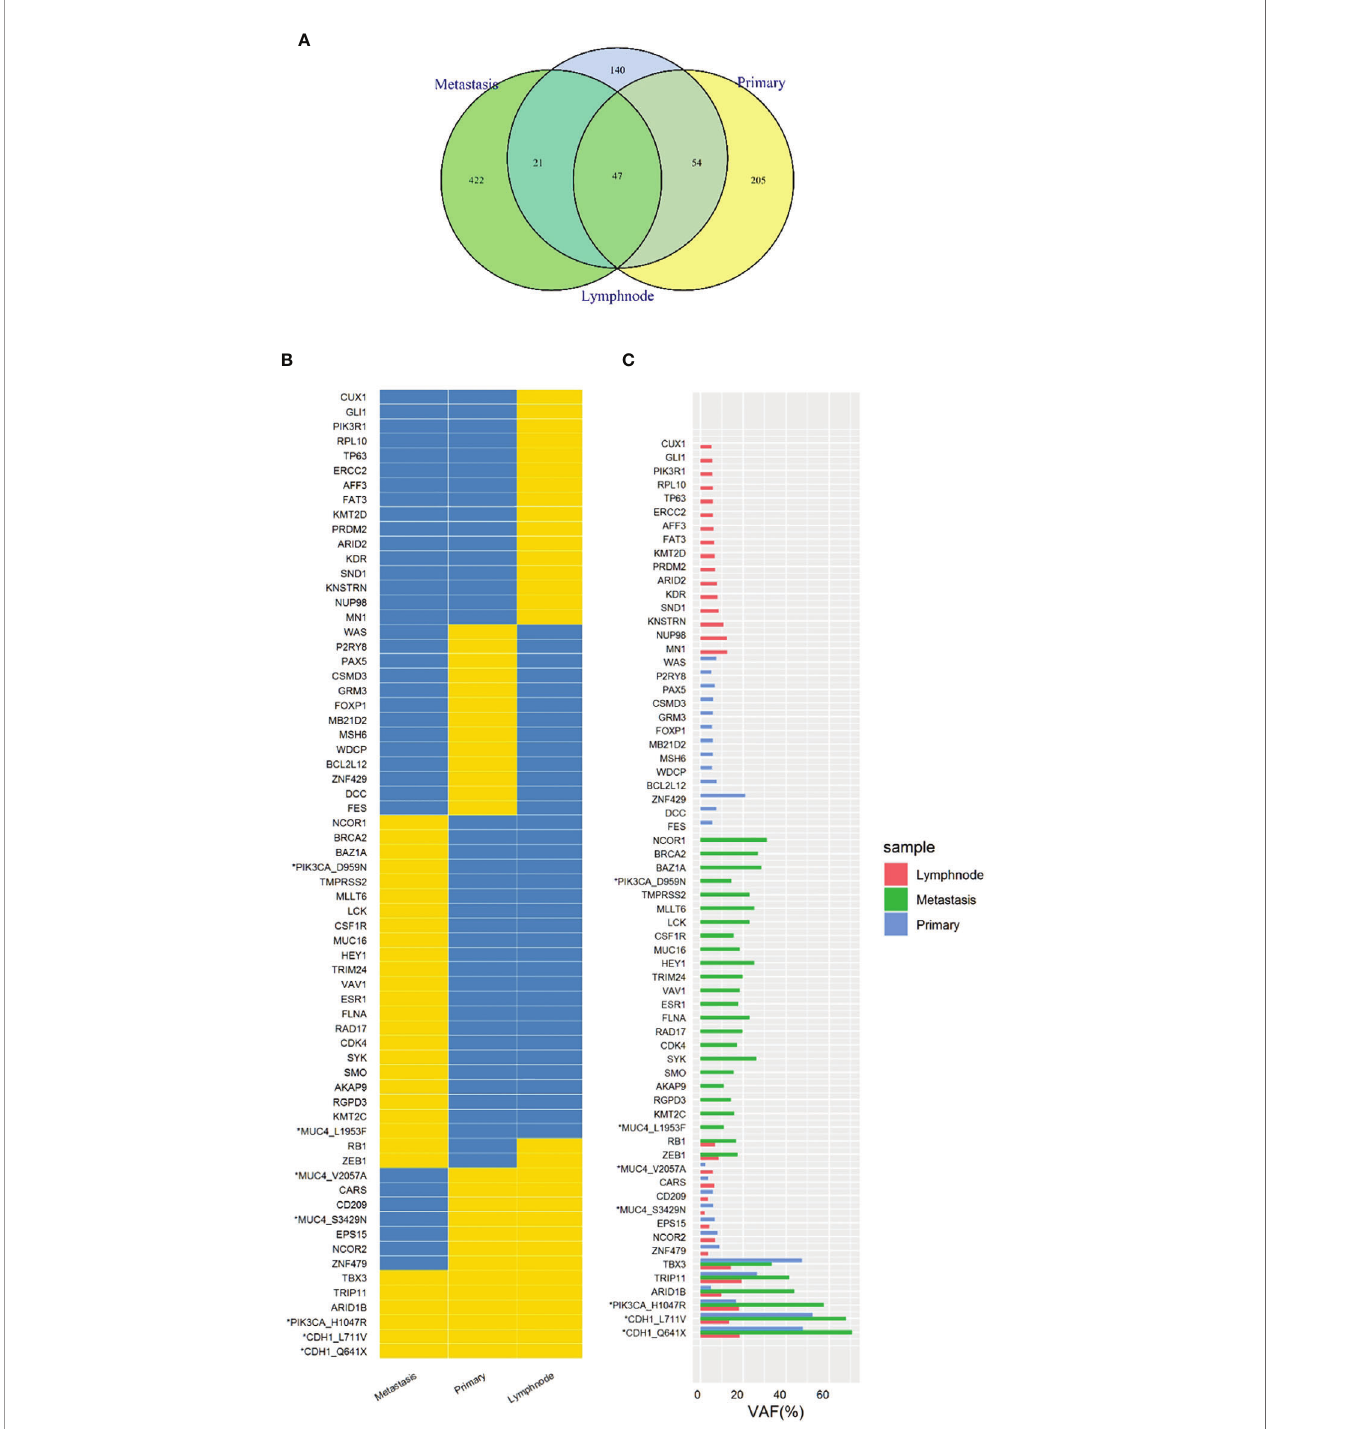
FIGURE 3 | Whole exome sequencing (WES) of tumor samples from primary lesion, regional lymph nodes and peritoneal metastatic lesions. (A) 3-way Venn Diagram showed the mutational overlaps in the three samples. There were 47 common mutations in the three samples, while another 21 common mutations between lymph node and metastatic site, and another 54 common mutations between lymph node and primary site. (B) Somatic mutation heatmap. The mark “ * ” means that there are 2 or more mutations in the same gene, which was labelled with gene or amino acid changes. Yellow means there is variation, while blue means there is no variation. (C) Variation frequency (VAF) distribution. The mark “ * ” means that there are 2 or more mutations in the same gene, which was labelled with gene or amino acid